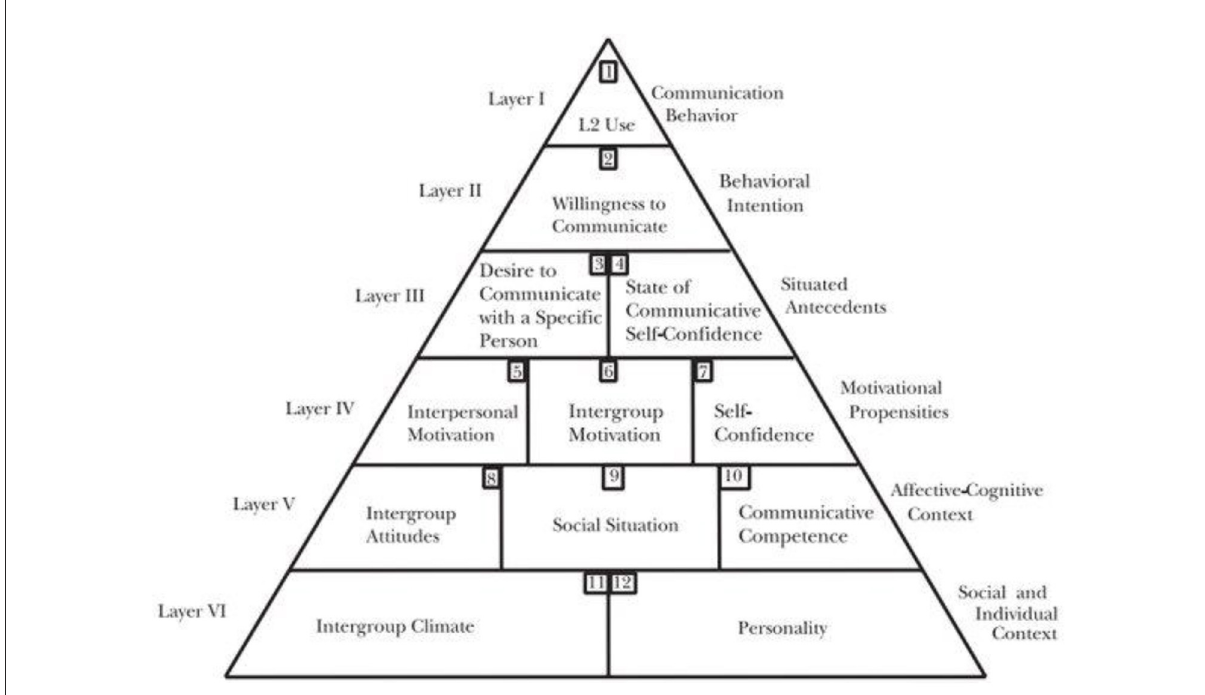
FIGURE1 Pyramid model of L2WTC (MacIntyre et al., 1998, p.